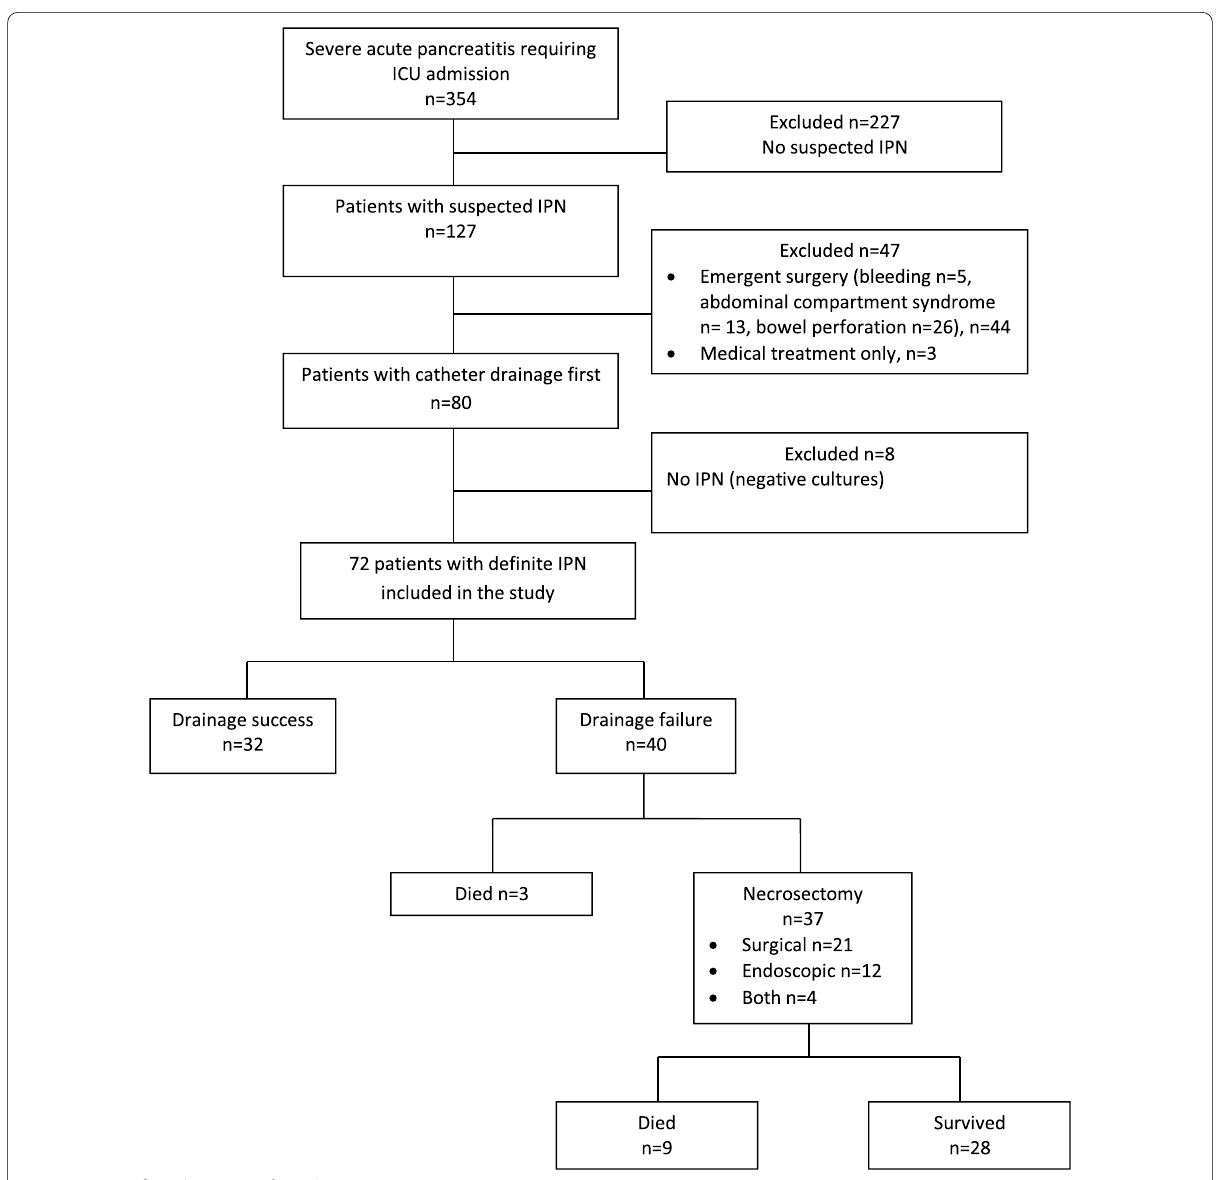
Fig. 1 Patient flowchart. IPN infected pancreatic